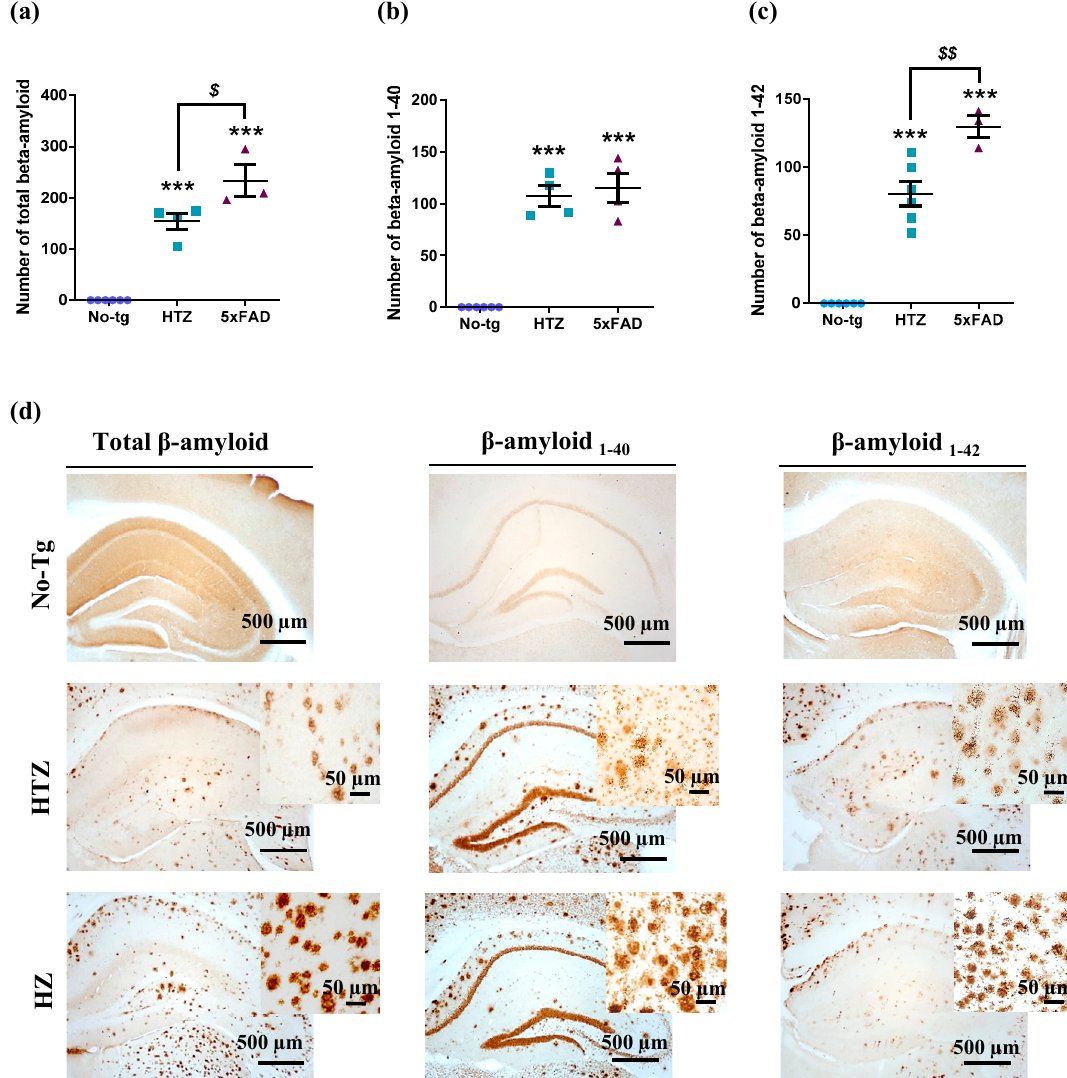
Figure 6. Amyloid- β (A β ) accumulation in the hippocampus of heterozygous and homozygous 5xFAD transgenic mice. Quantification of ( a ) total β -amyloid, ( b ) β -amyloid 1–40, and ( c ) β -amyloid 1–42 in the hippocampus of three groups. HZ 5xFAD mice exhibited a higher accumulation of total β -amyloid and β -amyloid 1–42 compared to HTZ mice. ( d ) The images correspond to representative total β -amyloid, β -amyloid 1–40 and β -amyloid 1–42 staining of the hippocampus of each group. Histograms represent the mean ± SEM ( n = 6). One-way ANOVA and Tukey’s test were performed: (***) p < 0.001 vs. No-Tg group; ($) p < 0.05 and ($$) p < 0.01 between HTZ and 5xFAD group. Scale bar = 500 and 50 μ m.